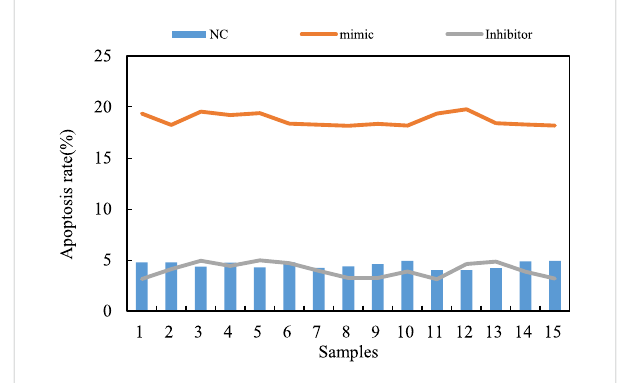
FIGURE 7 Regulation of miR-206 expression level on osteoblast